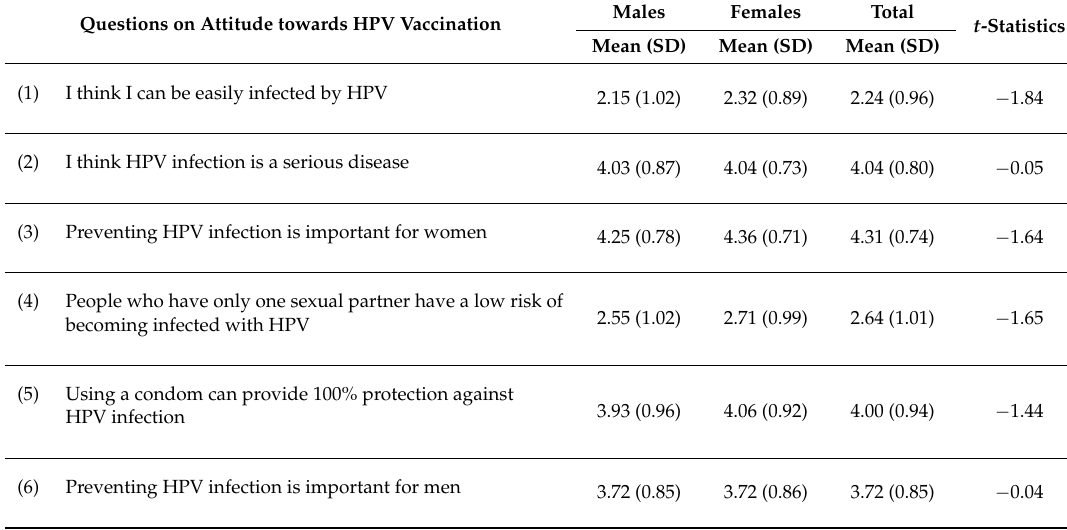
Table 4. Gender differences in attitude towards HPV